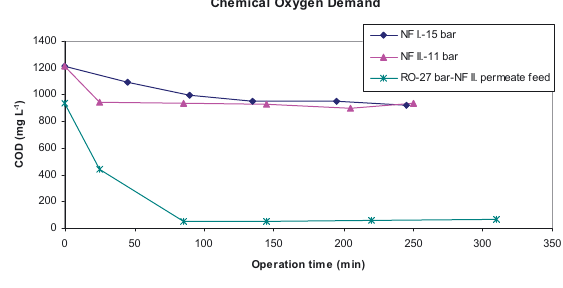
Figure 6. Permeate COD vs. operation time (wastewater of low